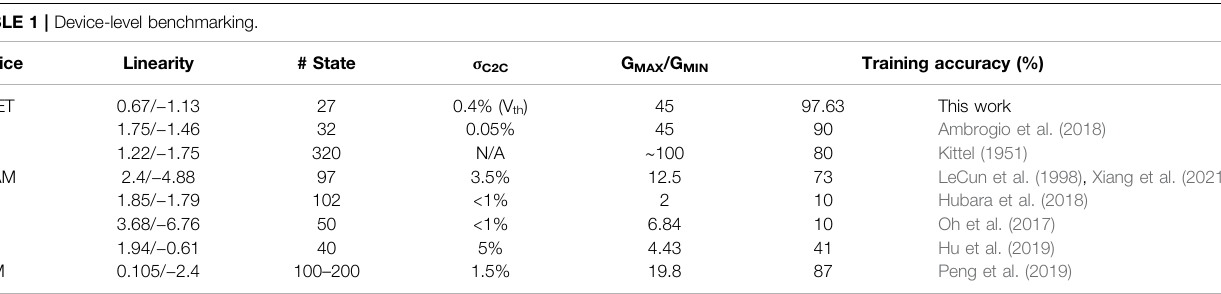
TABLE 1 | Device-level benchmarking.